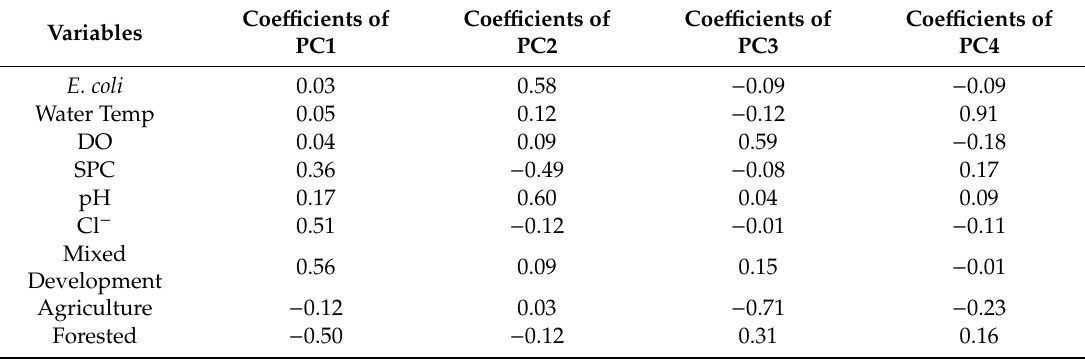
Table A9. Coe ffi cients of annual principal components comprising 9 variables ( E. coli concentration, water temperature, DO, SPC, pH, chloride, percentage of mixed developed land use, percentage of agricultural land use and percentage of forested land use) used to define 9 principal